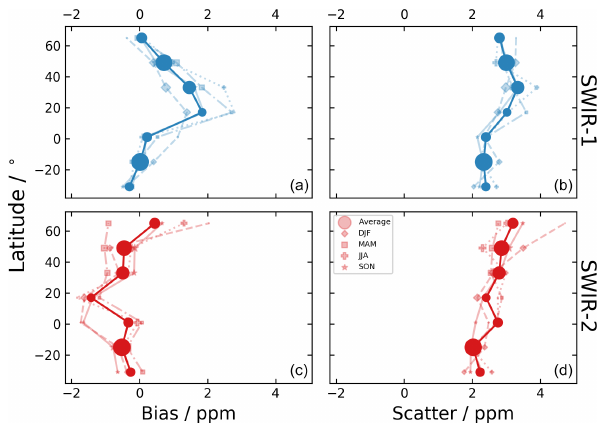
Figure 8. Retrieval bias (a, c) and scatter (b, d) with respect to native GOSAT XCO 2 over land as a function of latitude for the SWIR-1 (a, b) and SWIR-2 retrievals (c, d) in 16 ◦ bins. Bold circles indicate the average bias and scatter, while seasonal variations are shown for boreal winter (DJF, diamonds), spring (MAM, squares), summer (JJA, plus) and fall (SON, stars). Symbol size indicates the relative number of GOSAT observations over land in the respective latitudinal bin.